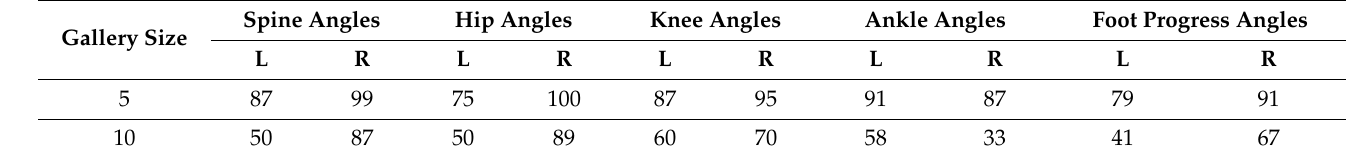
Table 2. Gait classifier recognition rates using lower-body angle trajectories.